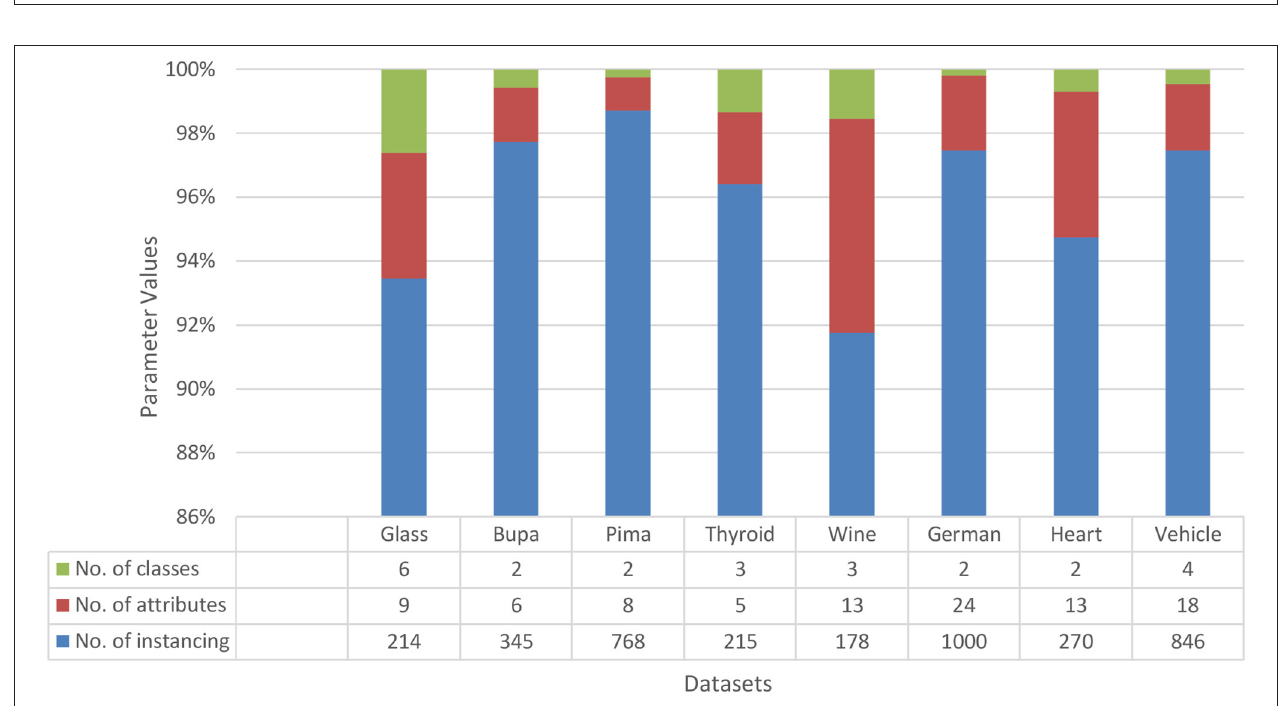
FIGURE 6 | Data sets for comparison with D.T. and VWDT.